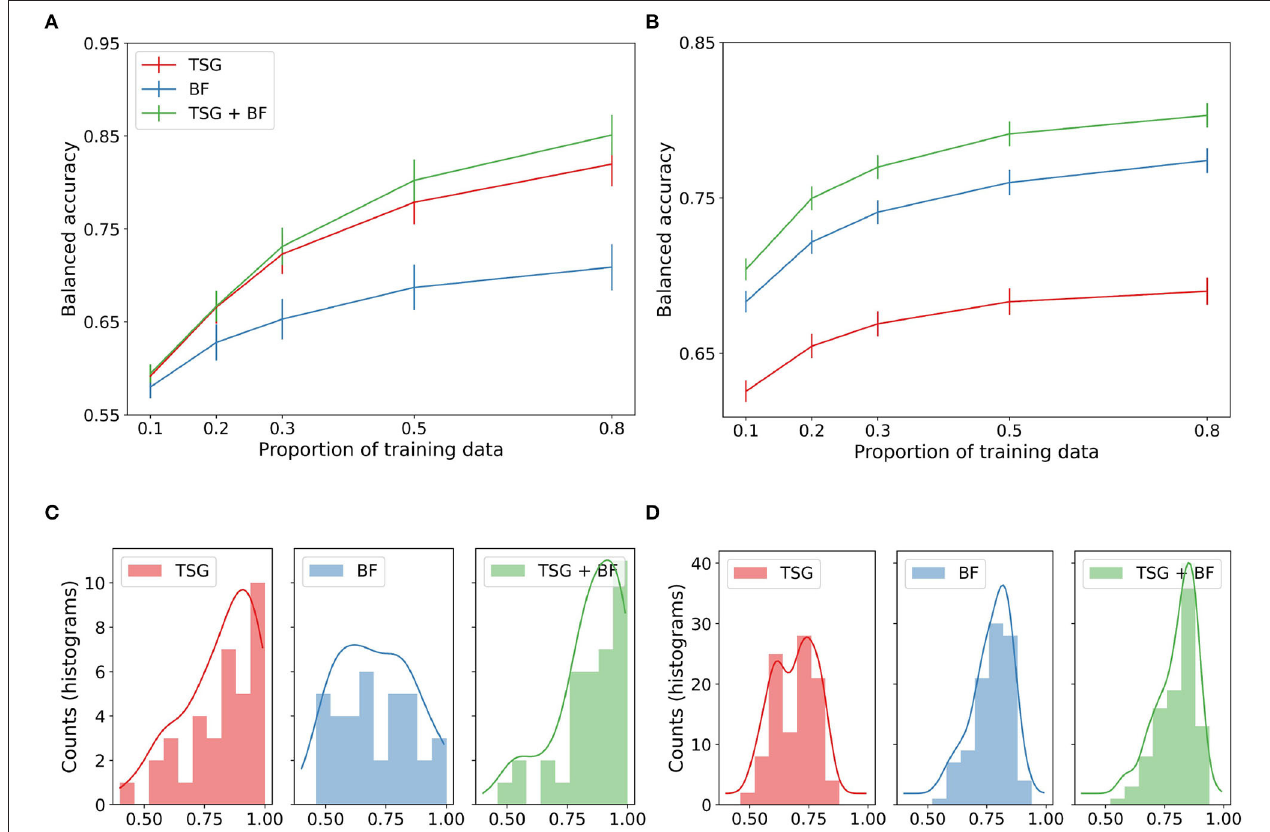
FIGURE 2 | In-session classification results. (A) Mental math. (B) MATB-II. (C) Histogram and estimated densities of in-session subject balanced accuracies at p = 0.8 for Mental Math. (D) Histogram and estimated densities of in-session subject balanced accuracies at p = 0.8 for MATB-II.